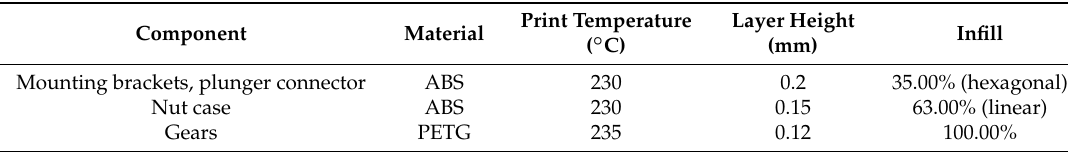
Table 1. 3D printed materials used for prototype fabrication.